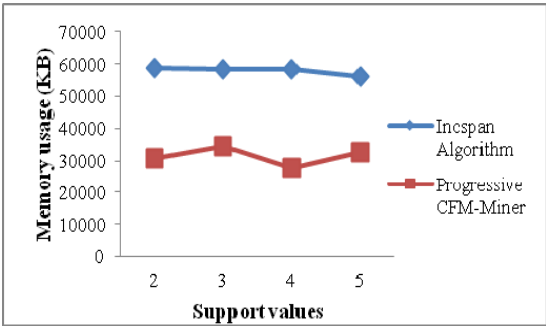
Fig.11. Memory Usages with Different Support